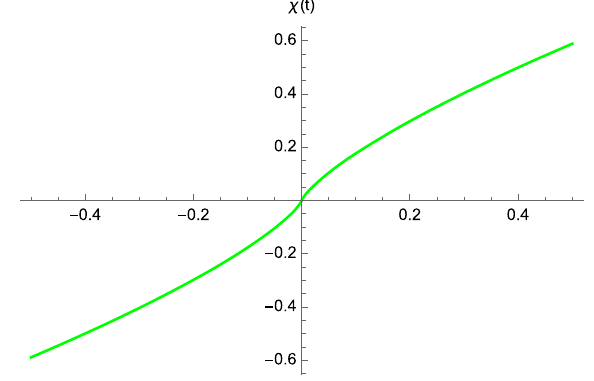
Fig. 4 Timelike geodesic of the non-comoving observer obtained by solving numerically Eq. (29) with the boundary condition χ(η = 0 ) = 0. The following constants have been chosen: R = 1 and (cid:23) = 1